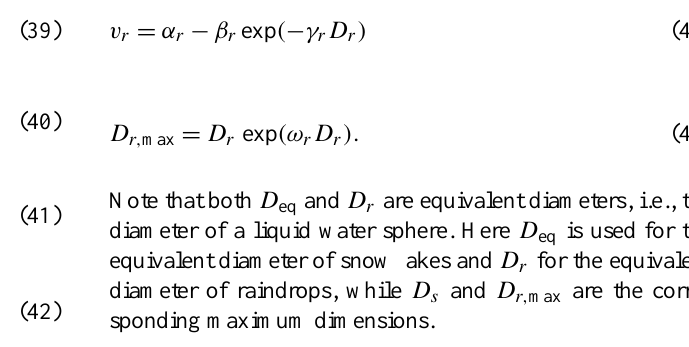
Fig. 4. Normalized mass collision rate for graupel and rain using different approximations (dashed) compared to a numerical solution of the collision integral (solid) as a function of the raindrop mean volume diameter for different mean volume diameters of the graupel size distribution.